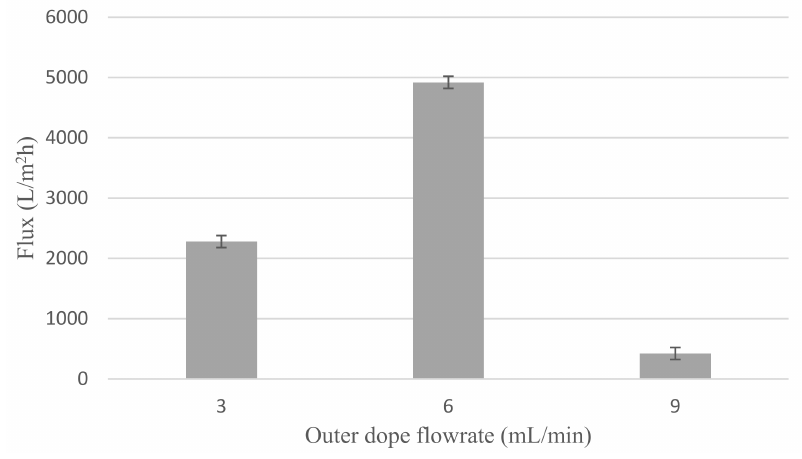
Figure 6. Water flux reading of 0.25 Cu 2 O/PVDF DLHF membrane for 3 mL/min, 6 mL/min and 9 mL/min outer dope flowrate. Table 3. SEM image and EDX mapping of neat PVDF membrane and Cu 2 O/PVDF DLHF membrane with 6 mL/min outer dope